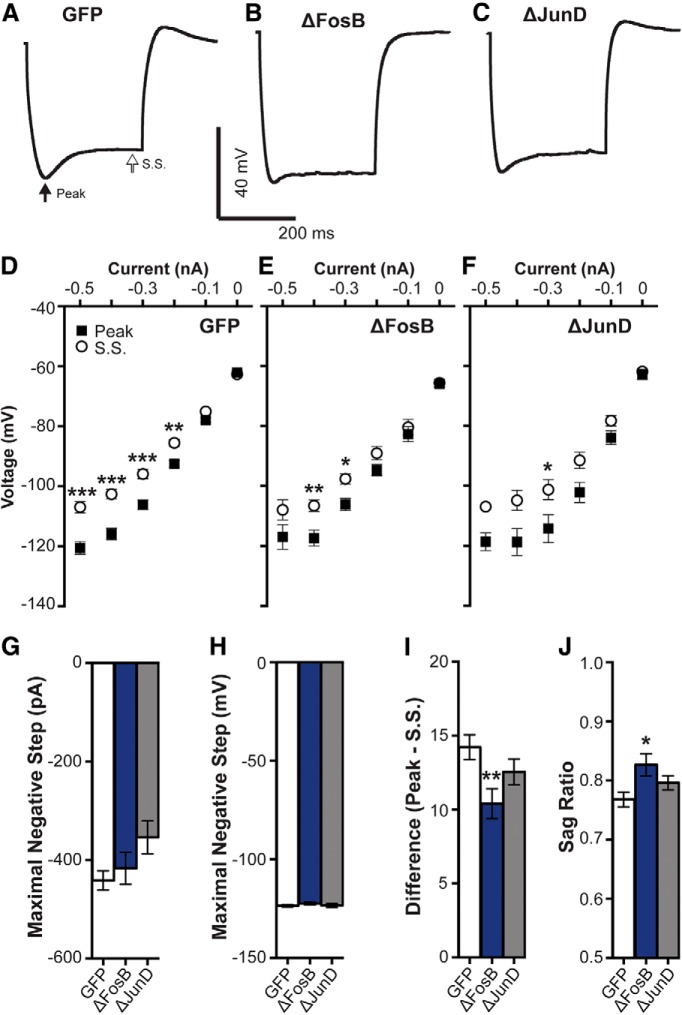
ΔFosB decreases Ih. A–C, Representative voltage trace to a hyperpolarizing current step showing Ih in hippocampal CA1 neurons expressing GFP (n = 21 cellls; n = 8 mice), ΔFosB (n = 19 cells; n = 9 mice), and ΔJunD (n = 13 cells; n = 5 mice), respectively. Arrows indicate amplitude measured at peak and S.S. D−F, I–V curves from hyperpolarizing current injections (0 to −500 pA) at peak and S.S. in GFP, ΔFosB, and ΔJunD cells. GFP cells had significant differences between peak and S.S. across currents (from −500 to −200 pA), indicative of Ih. ***p < 0.001 (two-way ANOVA; Holm–Sidak comparisons). Differences between peak and S.S. were comparably reduced in both ΔFosB (only different at steps −400 and −300 pA) and ΔJunD groups (only at −300 pA), indicative of reduced Ih. *p < 0.05, **p < 0.01 (two-way ANOVAs; Holm–Sidak comparisons). G, H, Mean maximal negative current and voltage (produced by maximal negative current), respectively, in GFP, ΔFosB, and ΔJunD cells. No differences were observed between groups; p > 0.05 (one-way ANOVA). I, Difference between peak and S.S. at maximal negative current across groups. ΔFosB significantly decreased the difference compared with GFP; **p < 0.01 (one-way ANOVA; Holm–Sidak comparisons). J, Sag ratio (S.S./peak at maximal negative current ratio) across groups. ΔFosB significantly increased the sag ratio (decreased Ih) compared with GFP; *p < 0.05 (one-way ANOVA; Holm–Sidak comparisons). All graphs display means ± SEM.